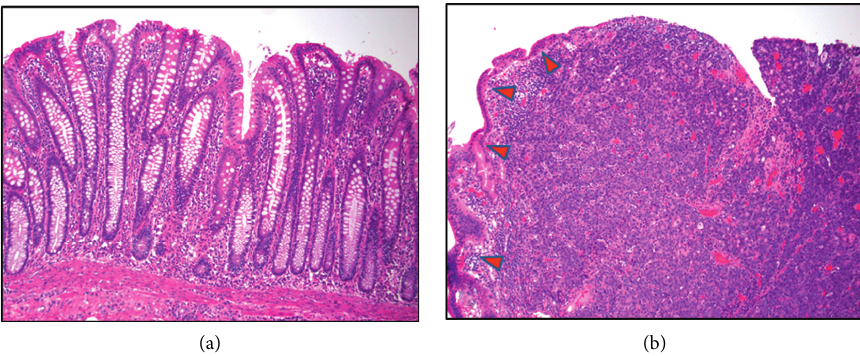
Figure 4: (a) Uninvolved colon from the colectomy specimen with minimal reactive changes and no significant acute or chronic in- flammation (100 × magnification). (b) Colon mass from the colectomy specimen showing poorly differentiated invasive adenocarcinoma with superficial ulceration, sheet-like architecture, and minimal gland formation undermining adjacent reactive colonic epithelium